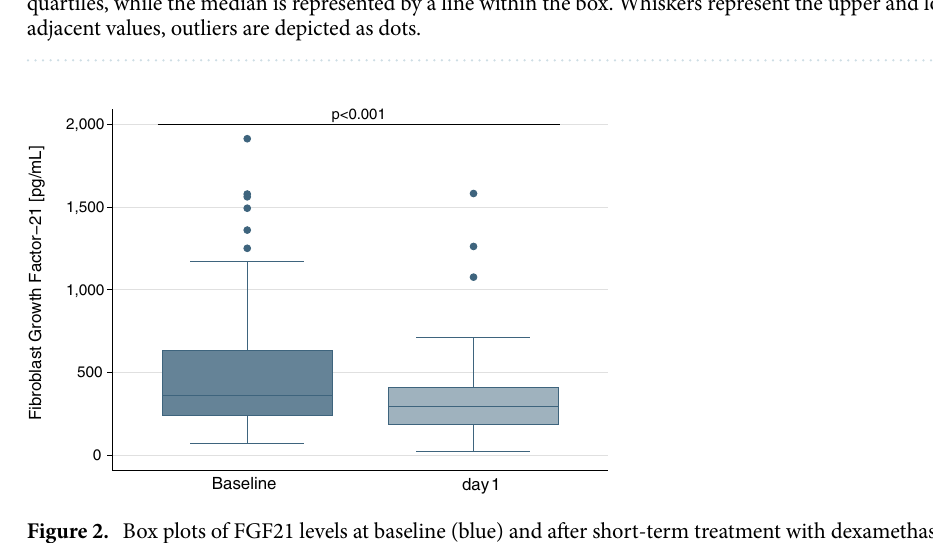
Figure 2. Box plots of FGF21 levels at baseline (blue) and after short-term treatment with dexamethasone (light blue) for patients from Trial A (n = 73). P-values were determined by Wilcoxon signed-rank test. Each box signifies the upper and lower quartiles, while the median is represented by a line within the box. Whiskers represent the upper and lower adjacent values; outliers are depicted as